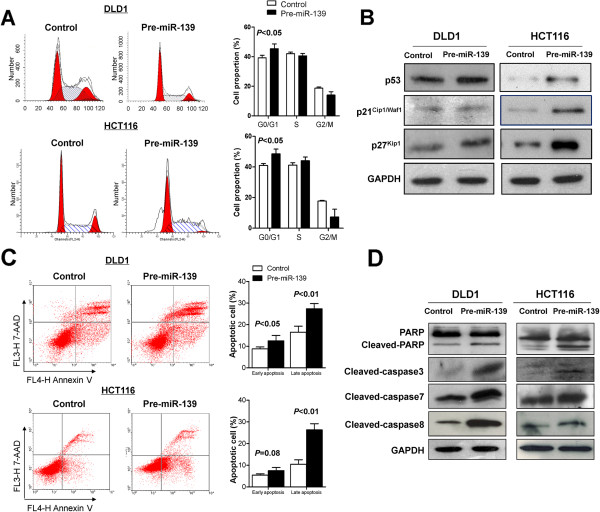
miR-139-5p induced colon cancer cell apoptosis and cell cycle arrest at G0/G1 phase. (A) miR-139-5p caused cell cycle arrest at G0/G1 phase in DLD1 and HCT116 cells (left panel). Quantitative analysis of G0/G1 proportion in DLD1 and HCT116, The experiments were repeated three times in triplicate. Data are mean ± SD. (B) G0/G1 phase cell cycle related protein expression including p21Cip1/Waf1, p27Kip1 and p53 were determined by western blot in DLD1 and HCT116 cells (C) miR-139-5p induced apoptosis in DLD1 and HCT116 cells. Cell apoptosis was examined by flow cytometry analysis of Annexin V-APC and 7-AAD double-staining. Data represented the average of the early and late apoptotic cells, respectively. (D) Apoptotic-related protein expression (PARP, caspase-3, 7, 8) were detected by western blot.